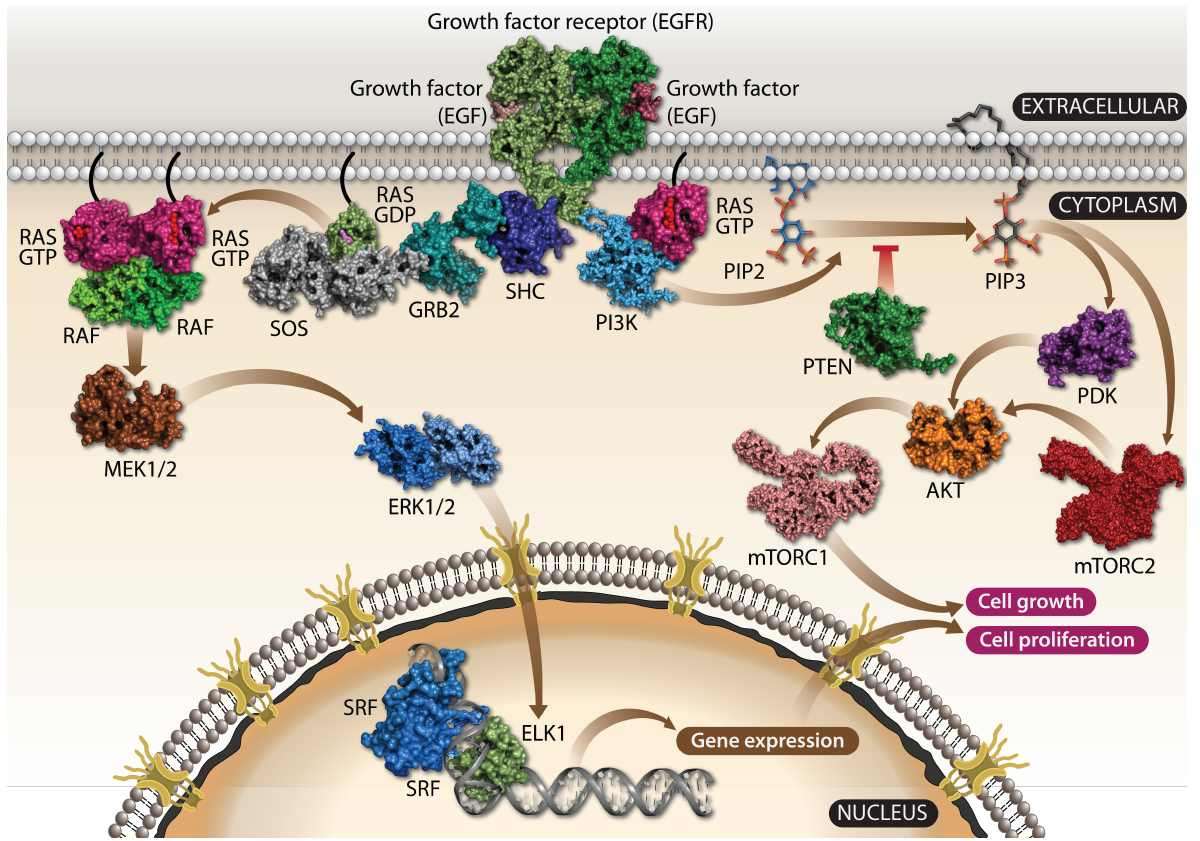
Figure 2. The RAF-MEK-ERK and PI3K-AKT-mTOR signalings are key RAS effector pathways.